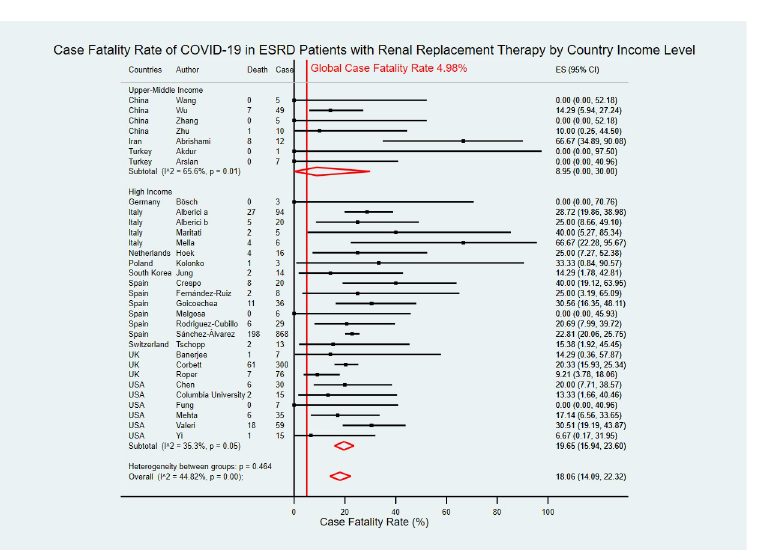
Fig 7. Forest plot of the case fatality rate of COVID-19 in ESRD patients with RRT by country income level. The figure summarizes the number of COVID-19 deaths in ESRD patients with RRT and the number of COVID-19 confirmed cases in ESRD patients with RRT in 31 eligible studies with subgroup analysis by the World Bank country income level. The forest plot represents the estimated case fatality rate of COVID-19 in ESRD patients with RRT for each study (black boxes), with 95% confidence intervals (95% CI; horizontal black lines). The estimated pooled case fatality rate for each subgroup was presented with a red diamond. The overall estimated pooled case fatality rate (last red diamond) was 18.06% (95% CI 14.09–22.32). The global case fatality rate (vertical red line) was 4.98%. The meta- analysis used a random-effects model with the exact method for confidence interval estimation. ES, effect size. I 2 , test for